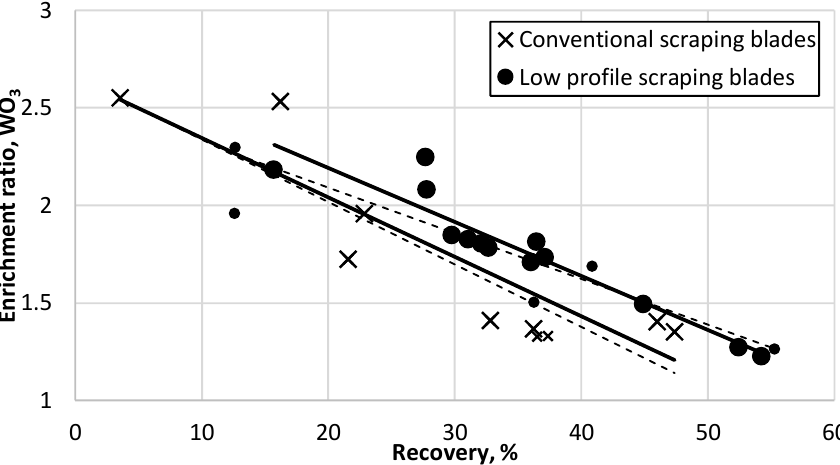
Figure 18. Enrichment ratio-recovery plot for comparable data points of low profile and conventional scraping blade tests. The solid lines indicate the fitted regression lines for points within 2 standard deviations of the mean. The dotted lines indicate the fitted regression lines for the points within 3 standard deviations.